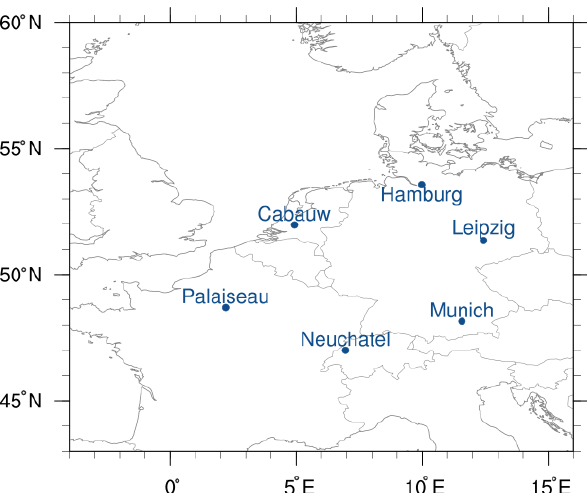
Figure 7. Map of EARLINET lidar measurement sites used in the